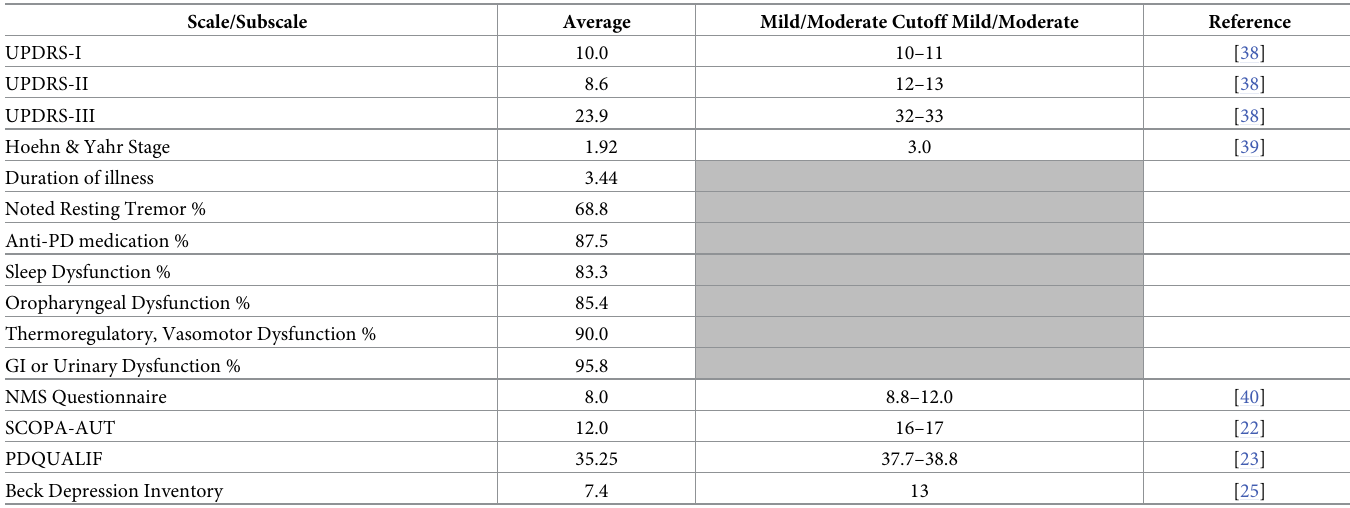
Table 2. PD subject characteristics.